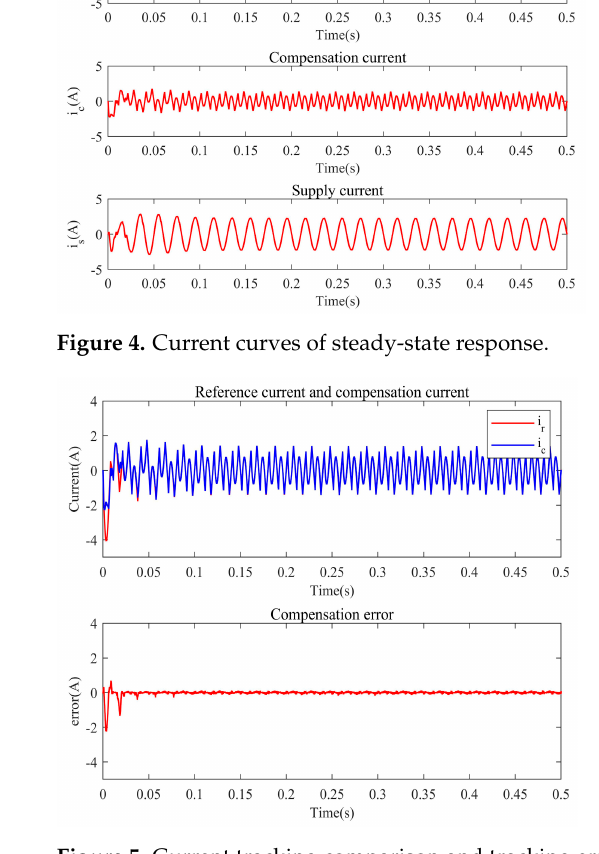
Figure 7. Spectrogram of supply current in steady state at 0.2 s. In addition, the estimated curve of IT2FNN for observer bandwidth